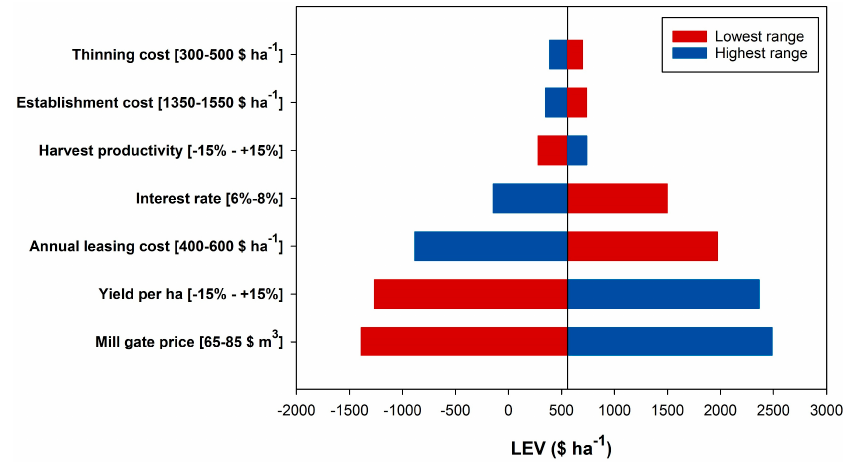
Figure 6. Tornado chart showing the effect of various factors on LEV (400 sph treatment). The lowest and highest range evaluated for each factor are shown in parentheses.